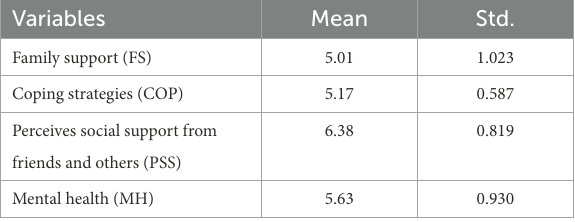
TABLE 4 Mean and standard deviation.